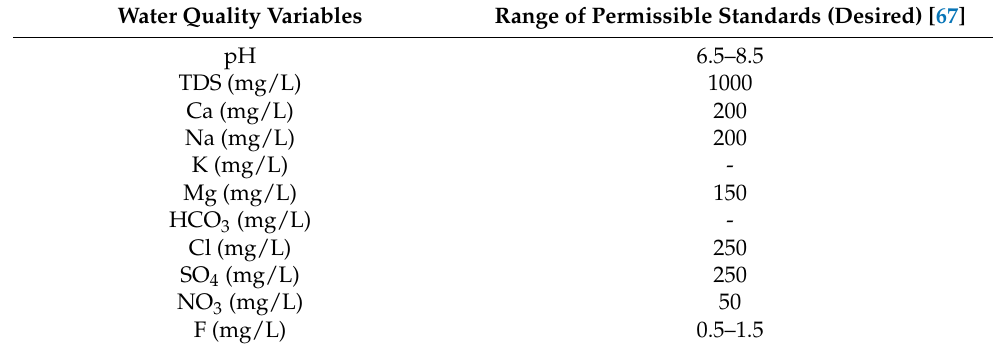
Table 3. SASO [67], Saudi Arabia, drinking water standards and the acceptable range of various physical